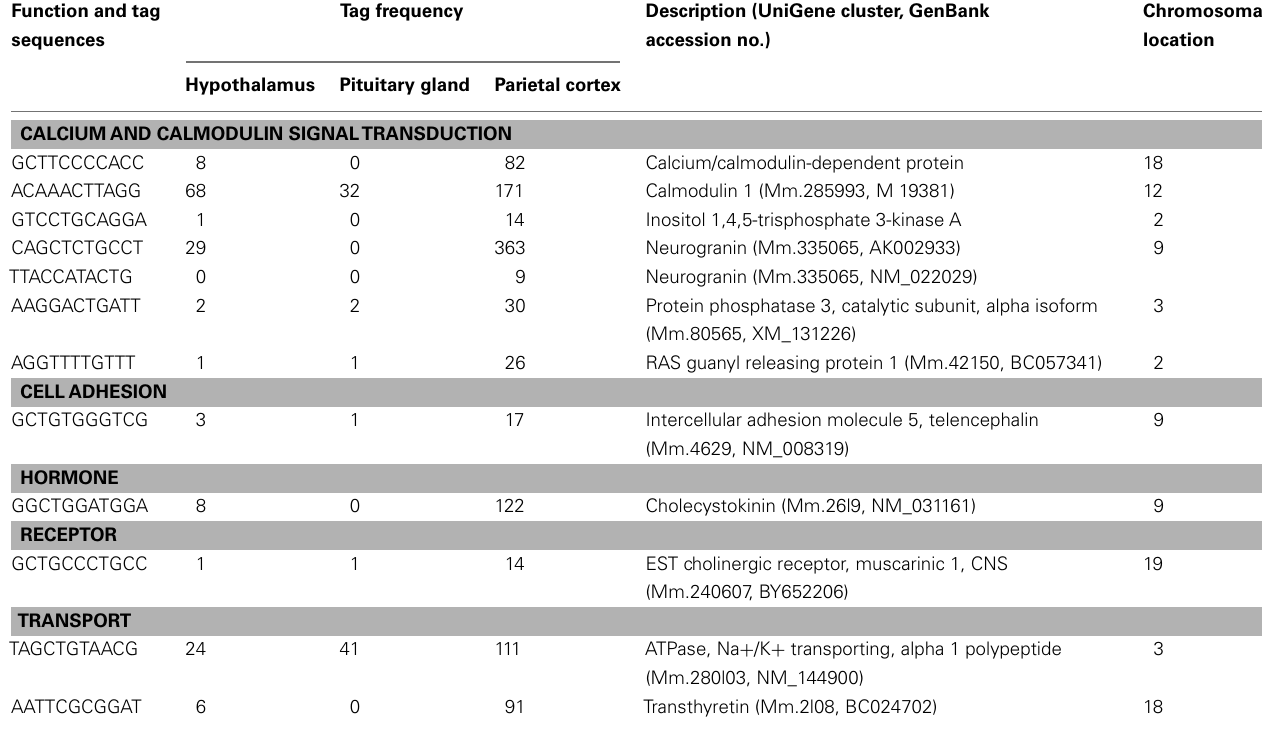
TableA1 | Components of cell signaling preferentially expressed in the